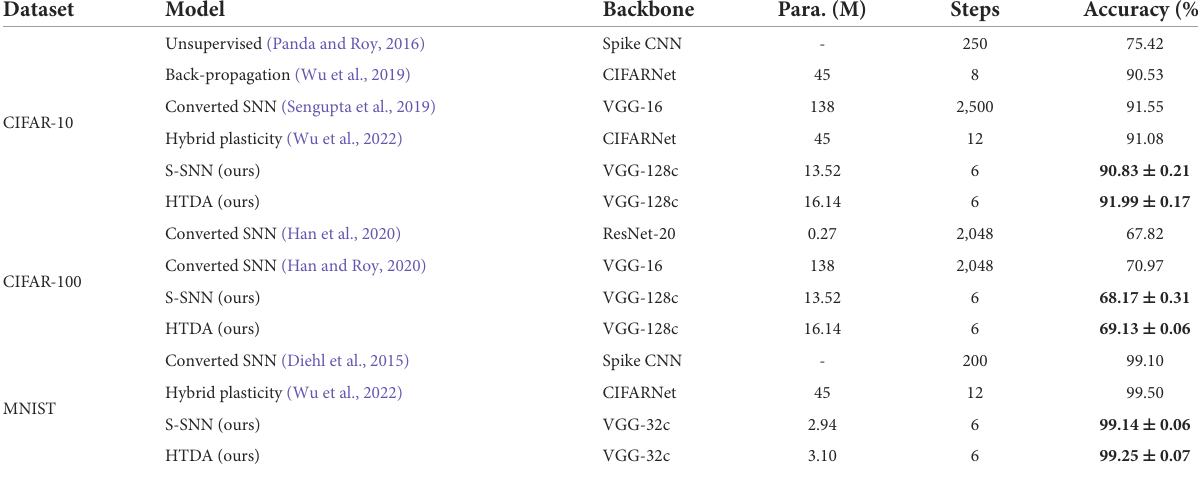
TABLE 6 Comparison of accuracy on CIFAR-10, CIFAR-100, and MNIST.